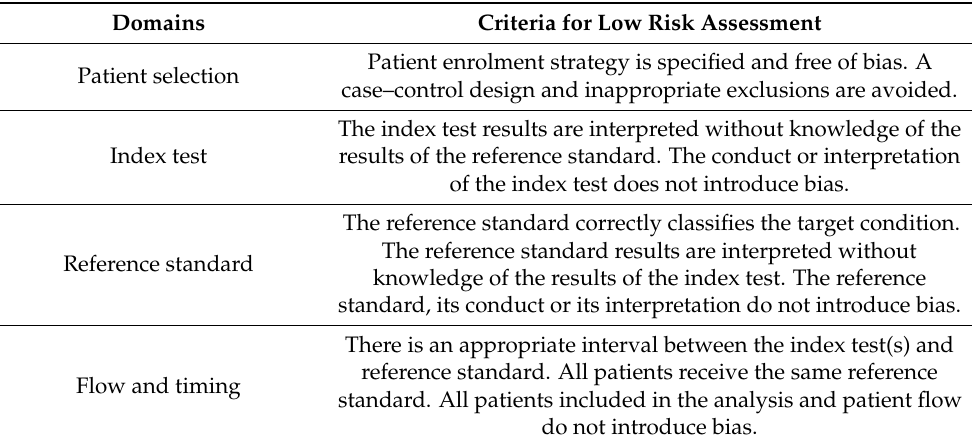
Table 1. QUADAS-2 risk of bias assessment criteria.